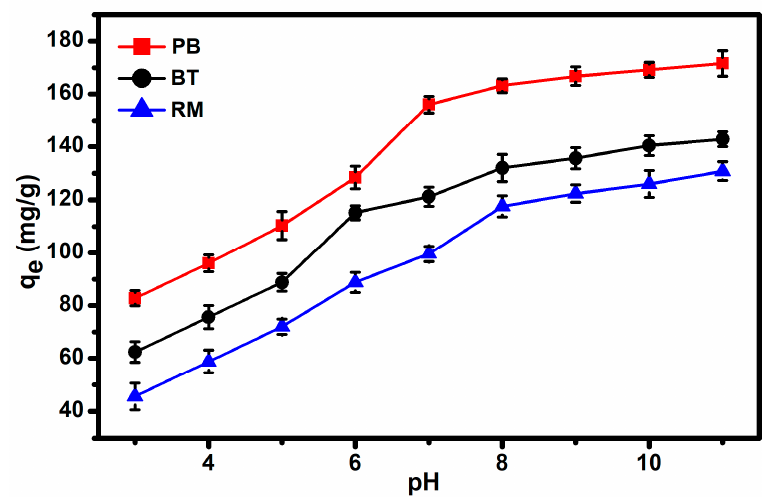
Figure 9. Effect of pH on MG adsorption.